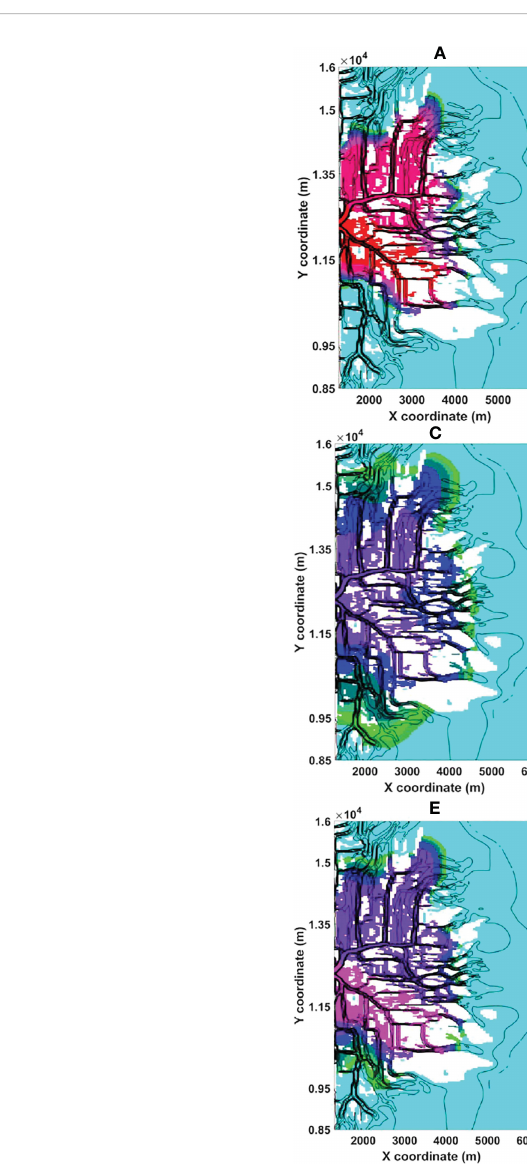
FIGURE 6 The time in days that salinity is less than 2 PSU in the delta for the (A) Platykurtic (B) Mesokurtic (C) Leptokurtic (D) Left and (E) Right skewed hydrograph cases. The black lines in the background delineate the delta channels. White coloured spaces denote dry areas. The river inlet has been taken out from the maps and the abscissa is set to start at the river mouth. Cyan coloured areas never become